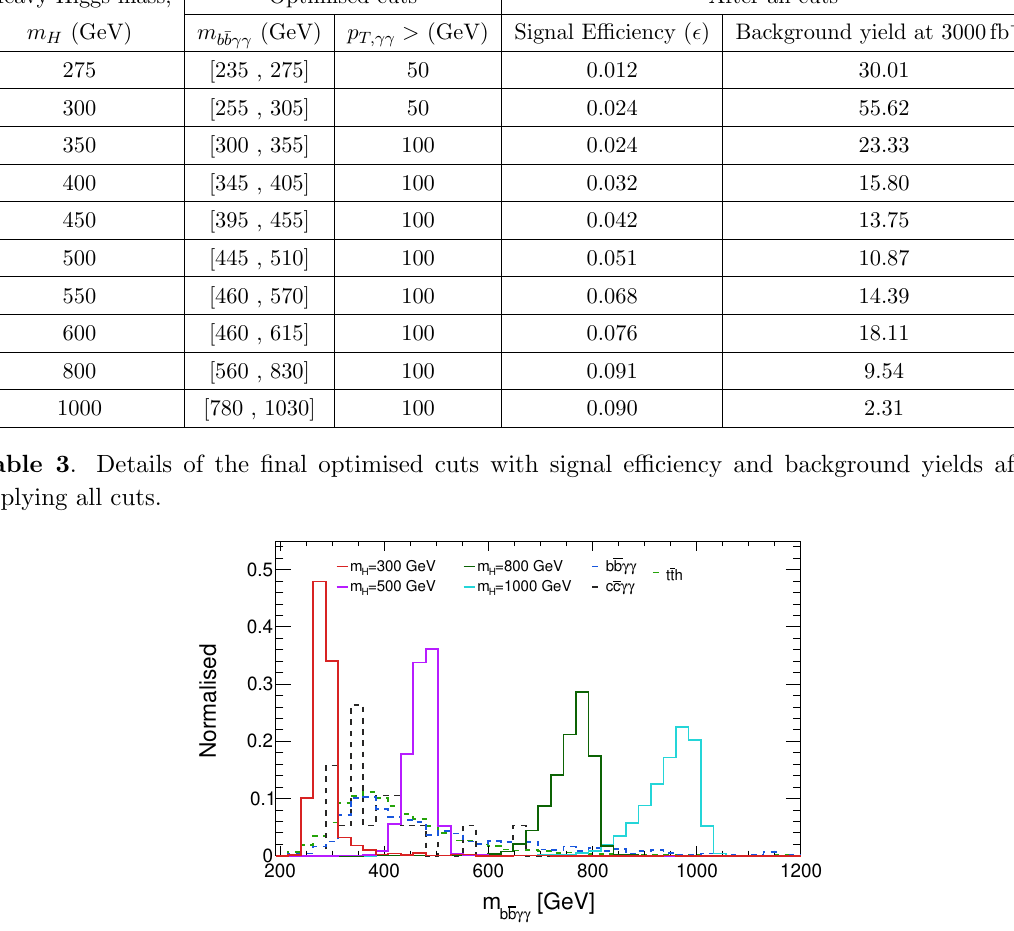
Figure 7 . Normalised distribution of m 1000 GeV with dominant